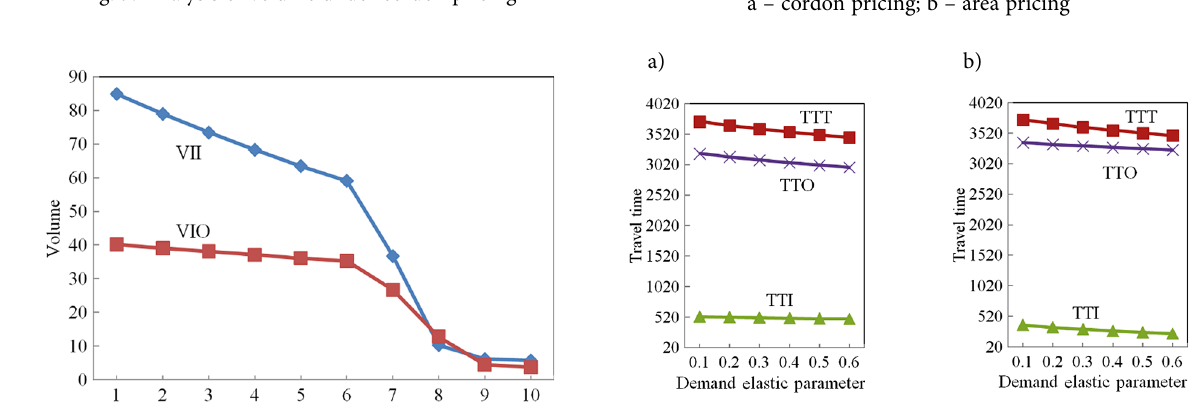
Fig. 7. Analysis of volume under cordon pricing